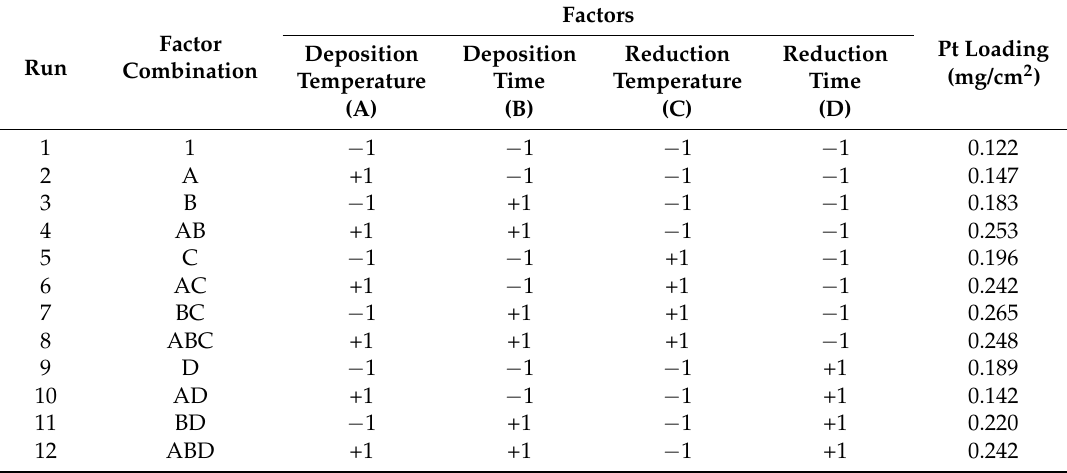
Table 2. Full 2 4 factorial design matrix and experimental